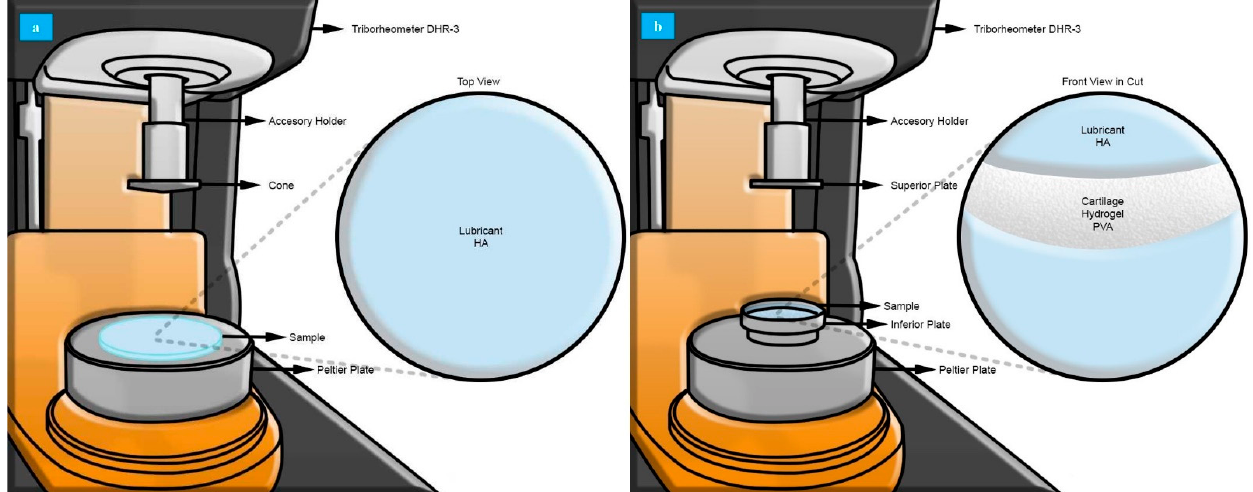
Figure 2. Characterization in a Discovery Hybrid Rheometer DHR-3. ( a ) Rheological study using cone-and-plate stainless steel configuration with an angle of 0.09969°, a diameter of 60 mm, and a truncation gap of 23 um. Samples used were 4 mg/mL hyaluronic acid (HA) solution. ( b ) Triborheological study using plate-and-plate stainless steel configuration with a diameter of 40 mm. Samples used were 10% polyvinyl alcohol (PVA) hydrogel with 5.0 ± 0.5 mm thickness and 45 mm diameter, hydrated with 4 mg/mL HA solution .